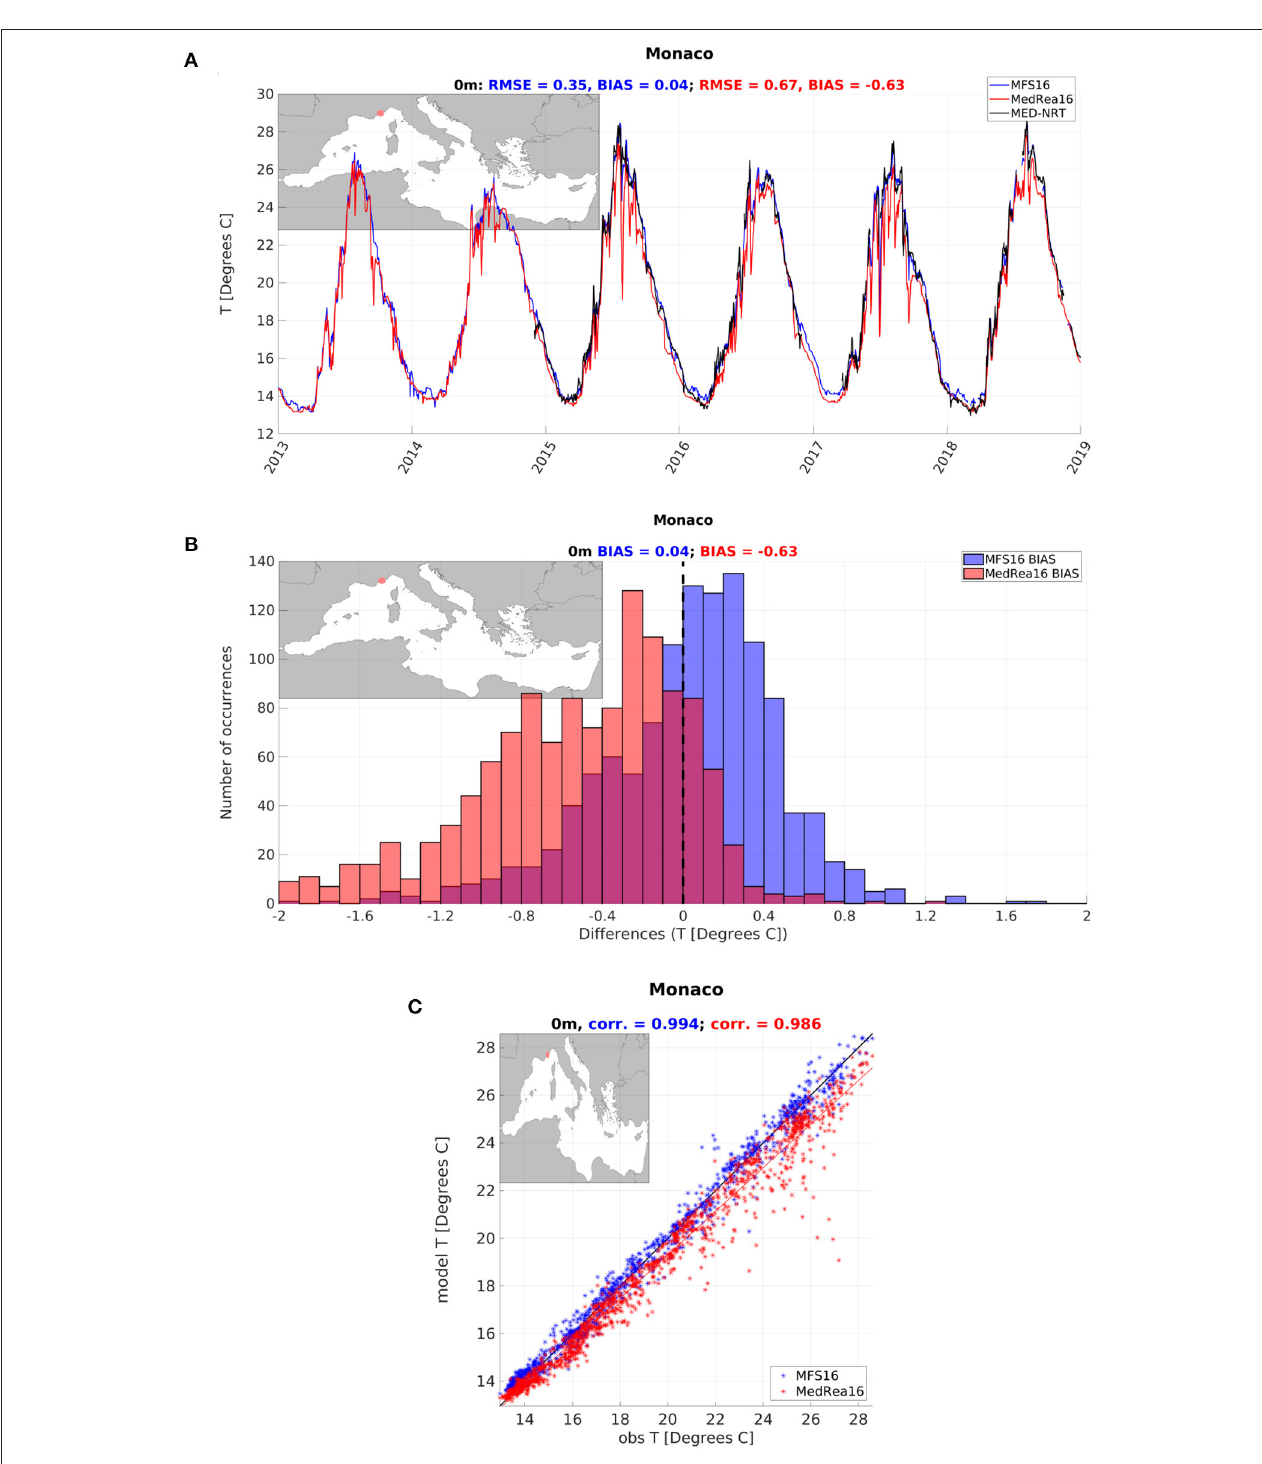
FIGURE 10 | Surface temperature validation of MedRea16 and MFS16 models at Monaco station: (A) synthetic and observed time series; (B) histogram of differences between model and observated temperature; (C) scatter plot of observed vs. model temperature.